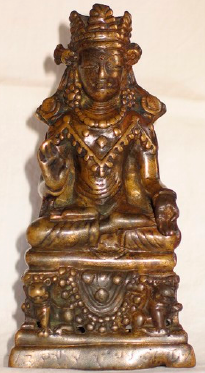
Figure 15. Buddha wearing a crown and jeweled cape, ninth c. Kashmir or Northern India. Bronze. Alan Robert Naftalis Collection. https://www.himalayanart.org/items/86315/images/primary#-1710,-